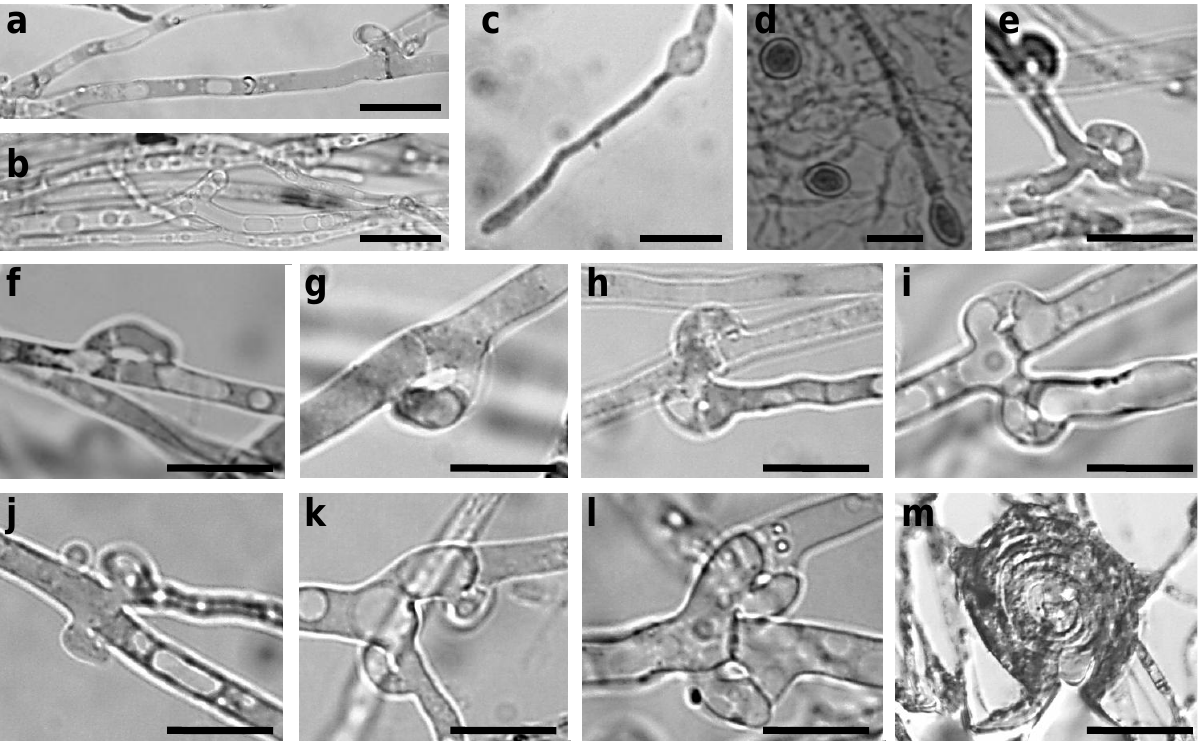
Figure 6. Micromorphological features of C. strossmayeri strains on MEA medium: (a, b) intensively vacuolated and granulated mycelium; (c, d) chlamydospores; (e–l) septa with and (h) without clamp cells; (m) hyphal loop; (a, b, e–l) strains 1-6S, (c) 15-1C, (d) 15-3C, and (m) 1-4S. Size bars correspond to (e–m) 10 µm, (a–c) 20 µm,